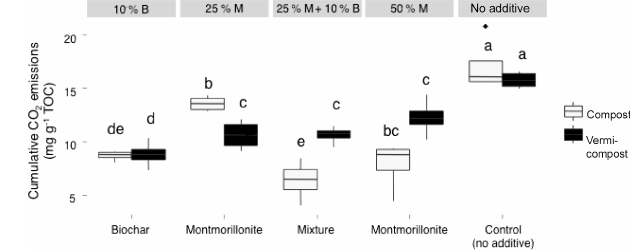
Figure 3. Total CO 2 emissions after 21 days of composting. Dif- ferent letters (a, b, c, d, e and f) indicate statistically significant dif- ferences.